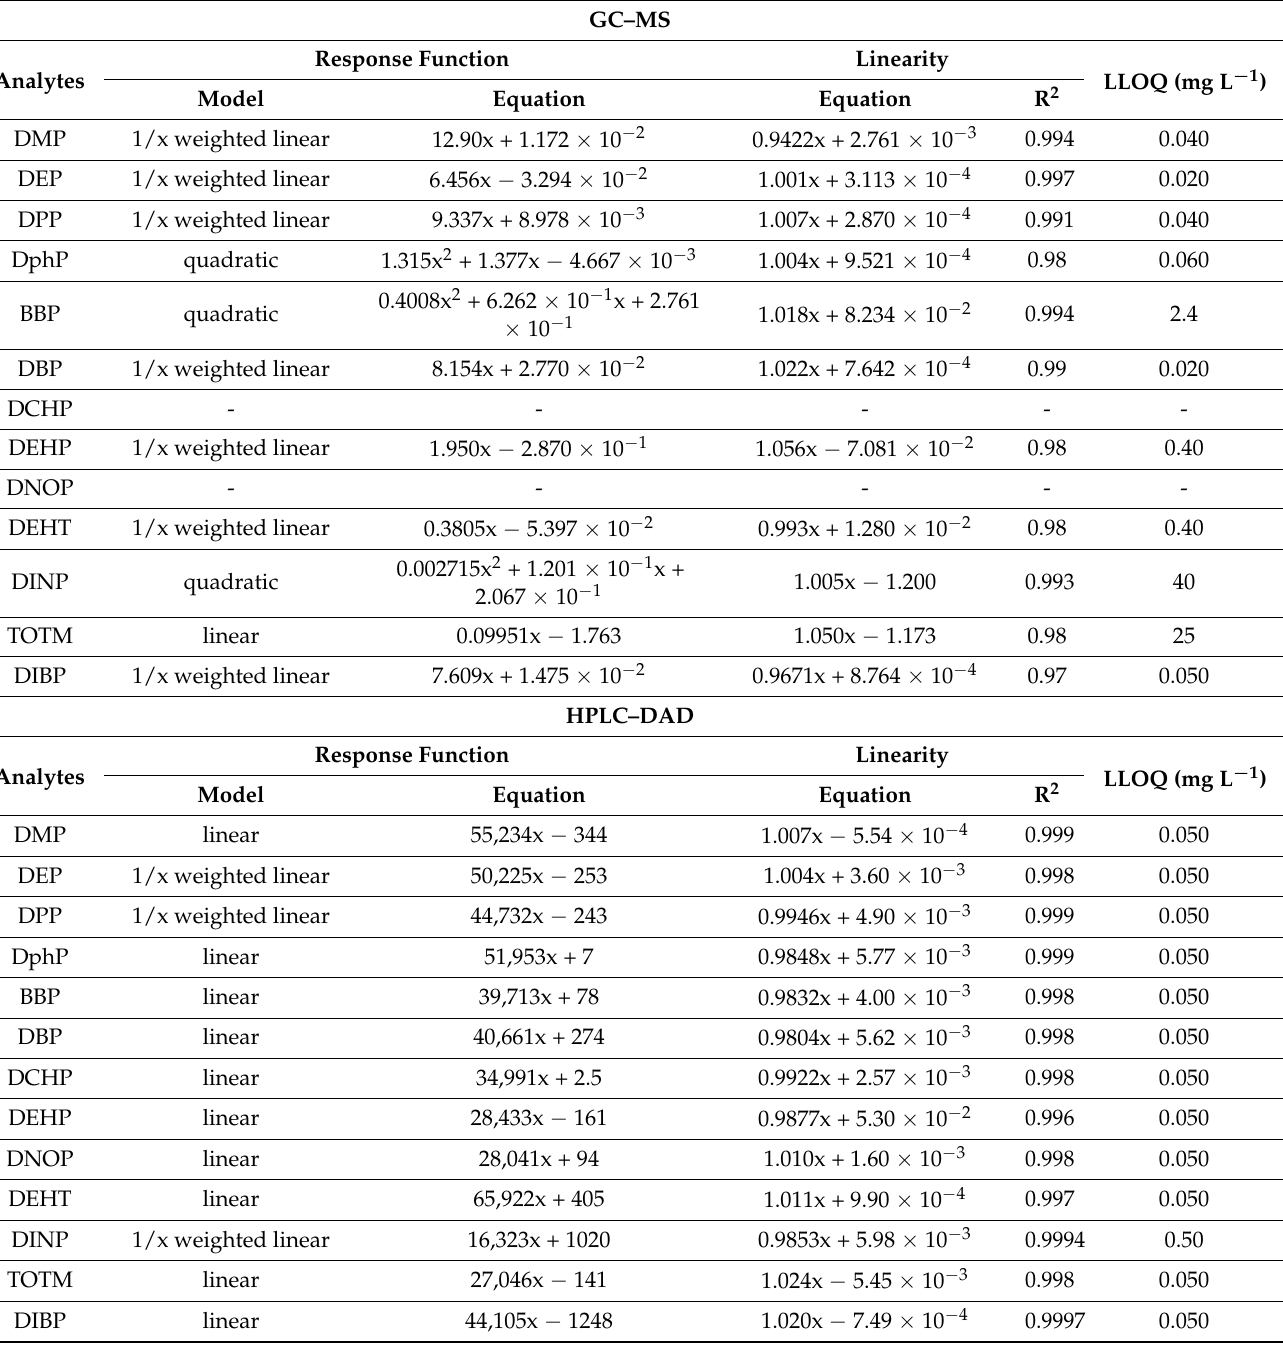
Table 3. Validation parameters (response function, linearity, and LLOQ) for the analysis of plasticizers by GC–MS and